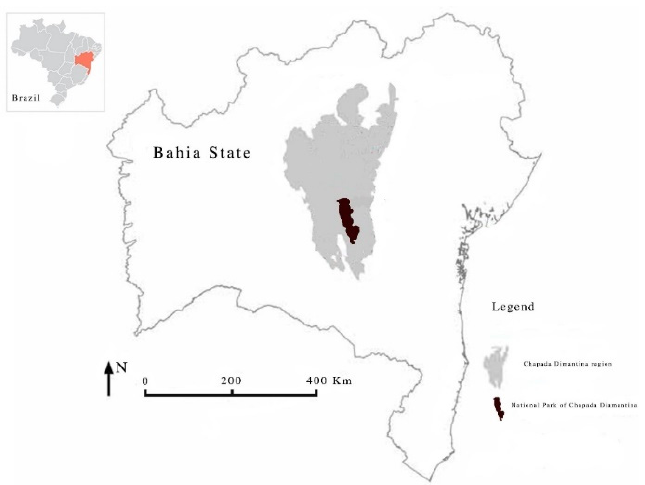
Figure 1. The study area of Bahia in Brazil (Source: prepared by the authors). The area of the Chapada Diamantina region has approximately 31,381 km 2 and a population of approximately 376,000 inhabitants, of which 50% are rural populations [19,20]. The area of this region is equivalent to the size of the Brandenburg state in Germany. For this study area’s territory, drought is classified as a very severe hazard (2000–2019), with moderate projection [21]. The study area region has a long history of managing and living among these challenging conditions related to drought [22].